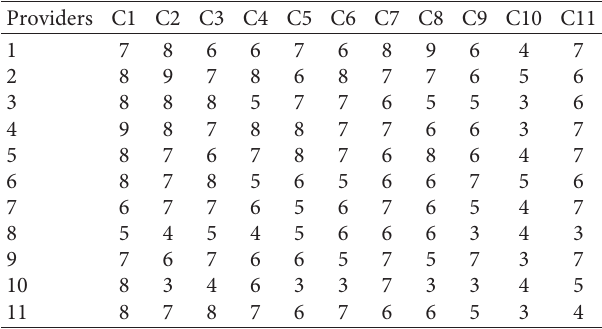
Table 3: The score of each index for candidate